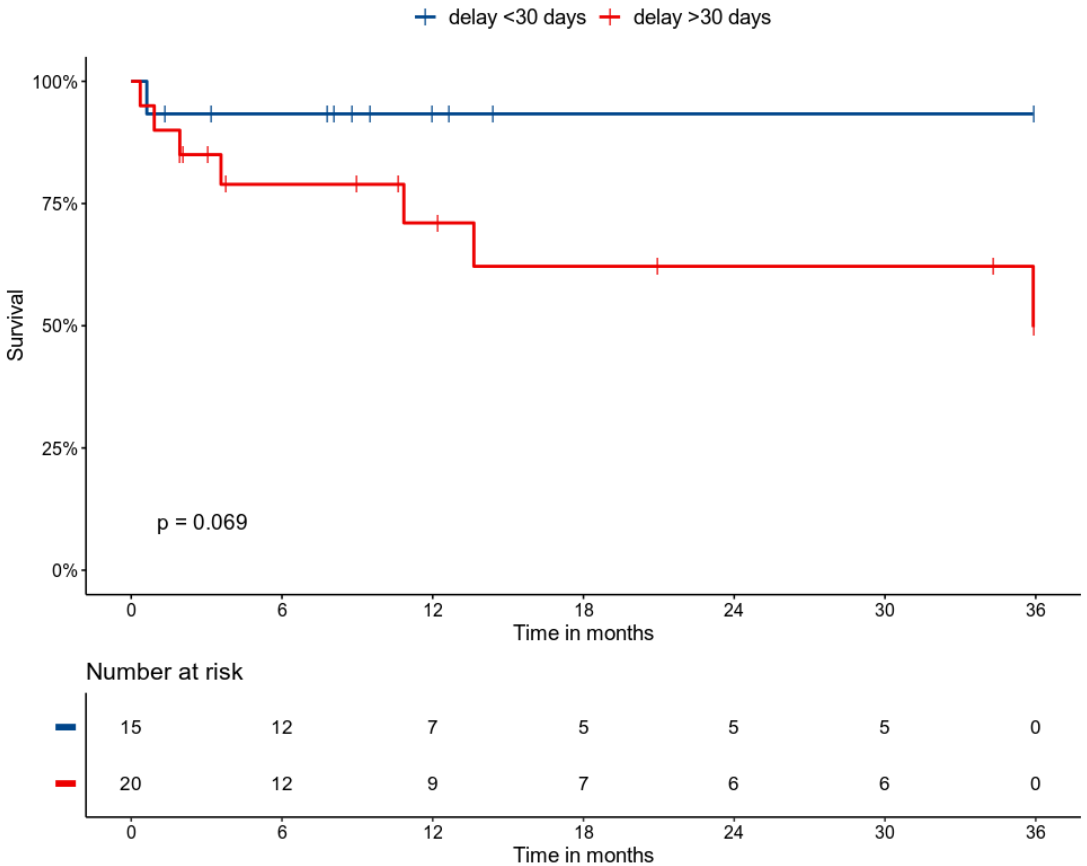
Figure 1. Kaplan–Meier estimates of survival in patients according to the delay between onset of symptom and accurate IE diagnosis, with between-group comparison by the log-rank test. Follow-up was right-censored at 3 years.